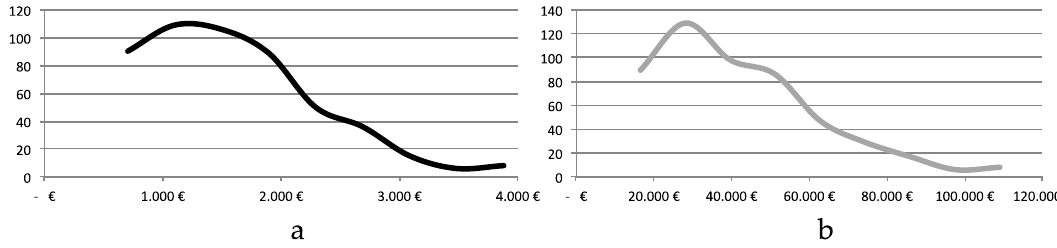
Figure 4. Frequency analysis of the prices of the sample euros/sqm ( a ) and euros/room ( b ).